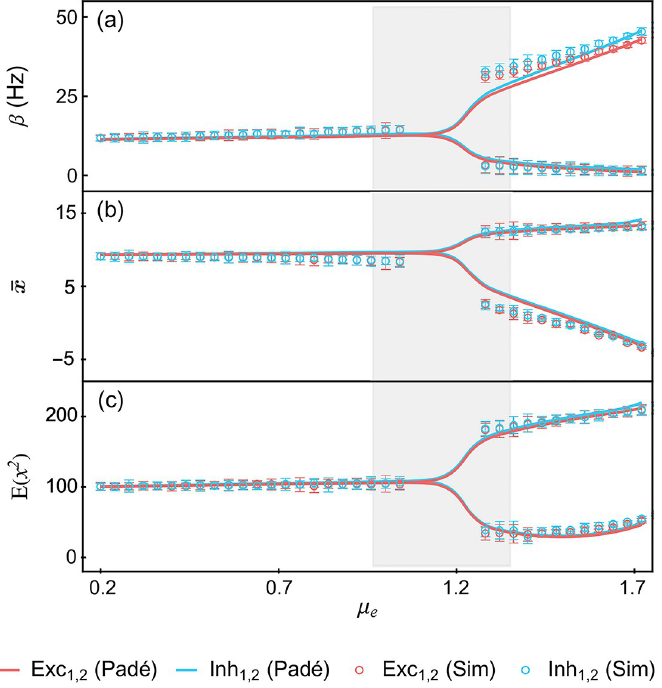
Fig 11. Mean firing rates β , mean internal variables � x and the second moments of the internal variables E ½ x 2 � for the bistable networks from RMF calculations and simulations. These figures shows in panel (a), the output rates β ; in panel (b), the mean internal variables � x and in panel (c), the second moments of x , with varying excitation strength μ e and fixed inhibitory strength μ i = − 4.0. Gray-shaded region is where the transition from monostable system to bistable system happened and we are not able to compute the simulated rates accurately, however, we can still perform RMF calculation within this region. For the simulated data, we run the event-driven simulation until 16000 spiking events for the entire network are accumulated. This process is repeated 32 times. During each repetition, we record the total time T k ( k = 1, ��� , 32) and total spiking event count S i , k for each neuron cluster i ( i = 1, ��� , 4). The mean firing P 32 rates of neurons are computed by � b ¼ ð = T Þ = 32 . The standard deviation of the rates (indicated by error S i i ; k k k ¼ 1